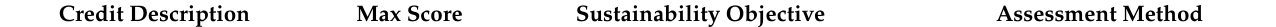
Table 2. Overview of the credits in the energy category, BREEAM-NL 2014 v2 (derived from the BREEAM-NL guideline). Credit